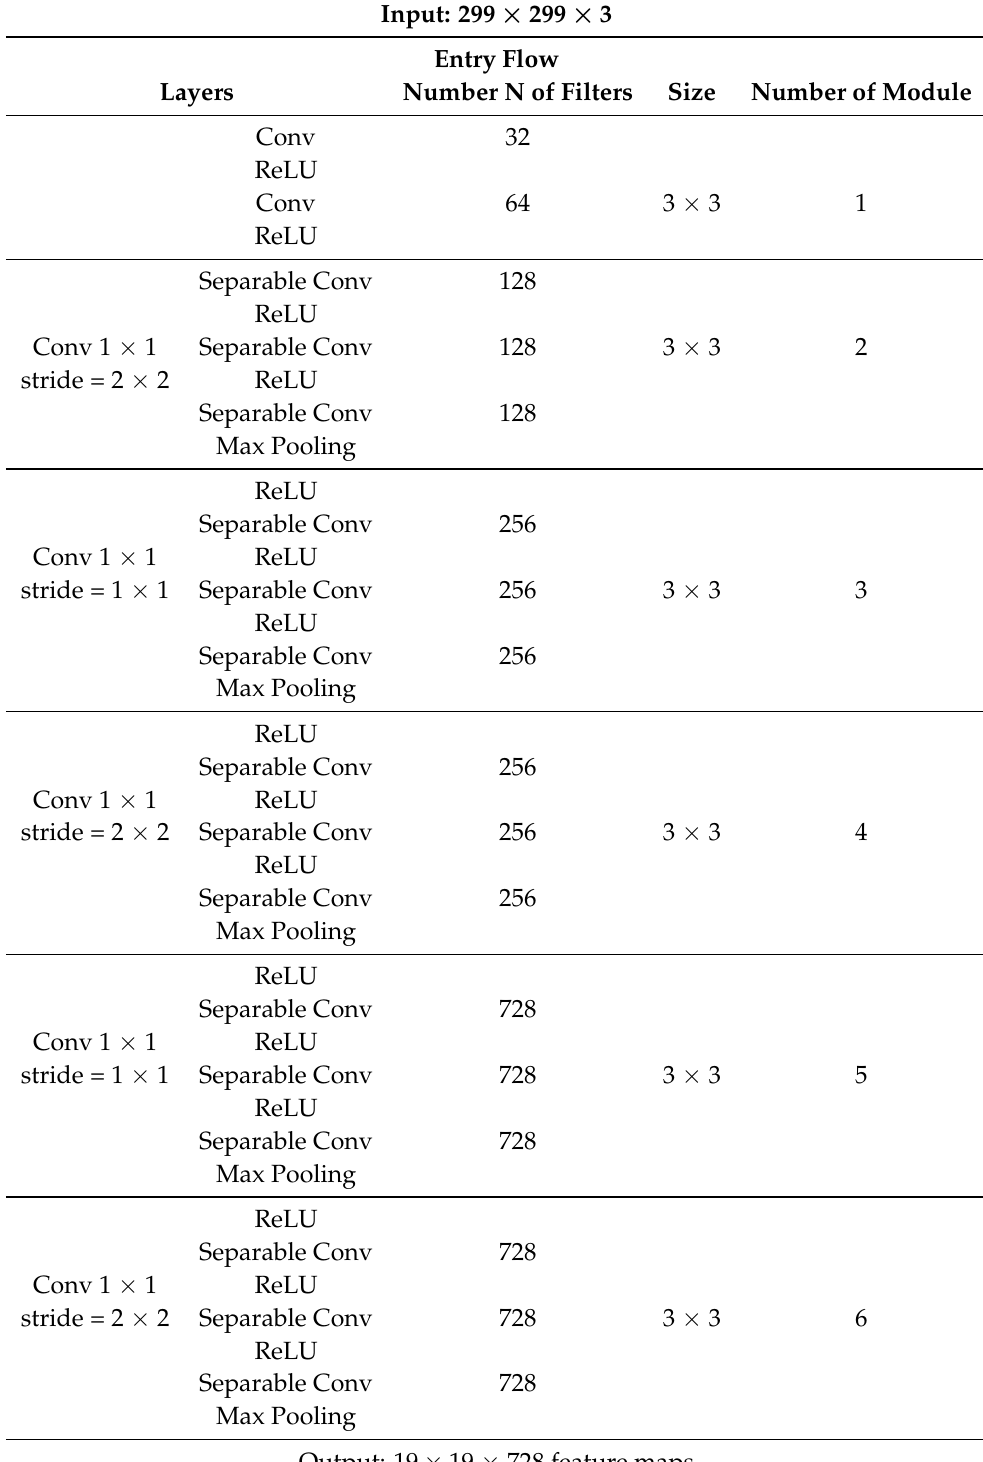
Table 2. Structure of the Entry Flow of the CNN model. All separable convolutional filters have a size of 3 × 3. All maxpool layers use the size F =